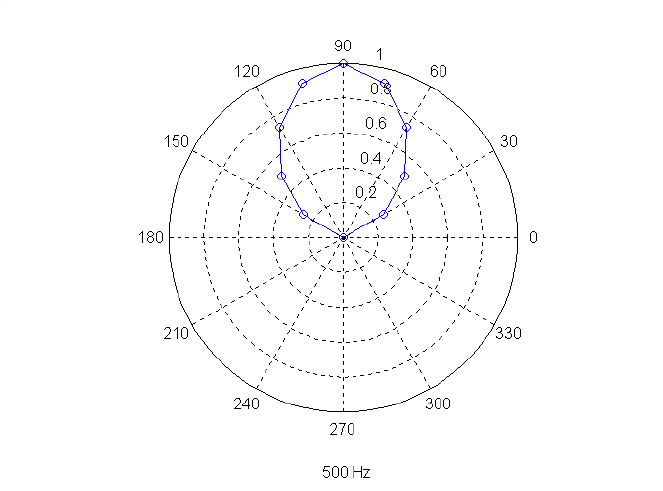
Figure 16. Experimentally obtained polar diagram of a 500 Hz resonant